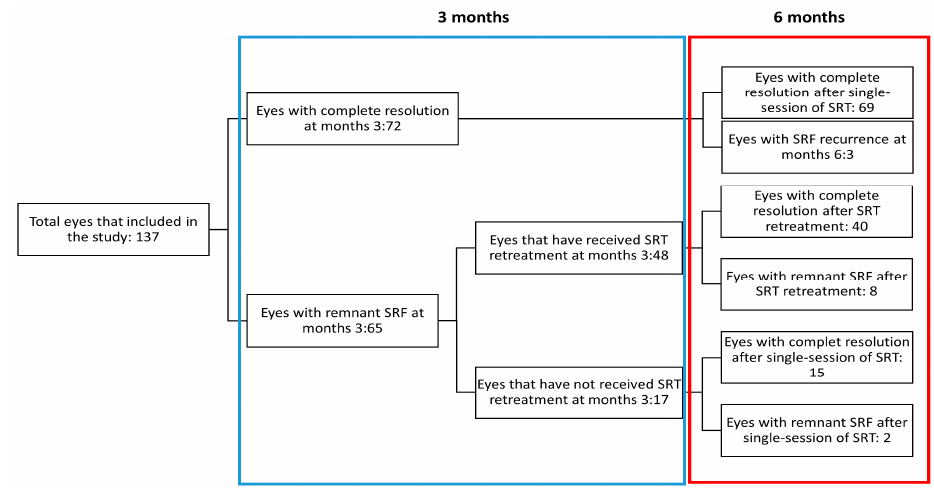
Figure 3. Flow-chart showing the rate of complete subretinal fluid resolution at 3 months and 6 months following selective retina therapy. Table 5. Comparison of baseline characteristics between single-selective retina therapy group and retreatment group with chronic central serous chorioretinopathy patients who showed complete subretinal fluid